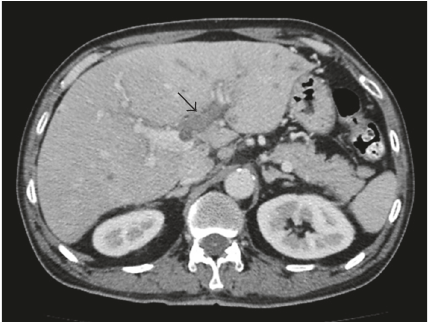
Figure 2: Axial computed tomography (CT) scan (portal venous phase) shows thrombosed left portal vein (arrow). Multiple small periportal vessels, which represent dilated collateral veins, which is the so-called cavernous transformation. Left portal vein thrombosis caused transient hepatic attenuation differences (THAD) between the left and right lobes of the liver.